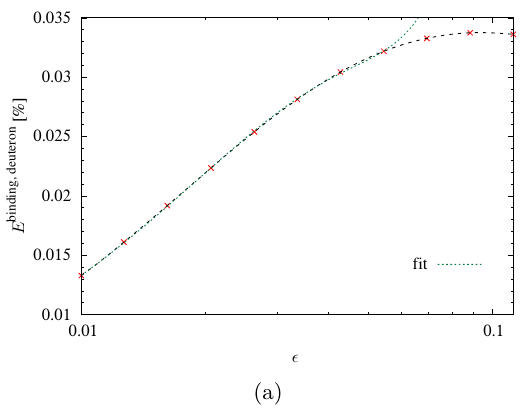
Figure 10 . The binding energy per nucleon in percent for two B = 1 Skyrmions, i.e. the N 2 LO energy at a = ∞ minus that at a = 0 , as a function of (cid:15) . The physical binding energy of deuteron per nucleon for comparison is 0 . 118% [44]. In this figure c 2 = 1 , c 4 = 8 , c 6 = 1 R = (3 π ) 1 3 and ( s, p ) = (1 , 2)